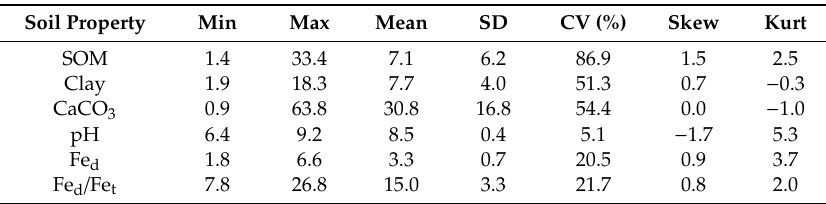
Table 1. Basic statistics for six soil properties.